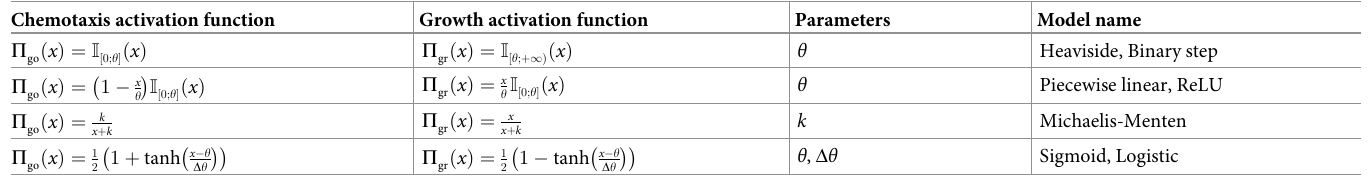
Table 1. Different functional relationships defined for the validation procedure. The different functions include features such as different smoothness and nonlinearities. Chemotaxis activation